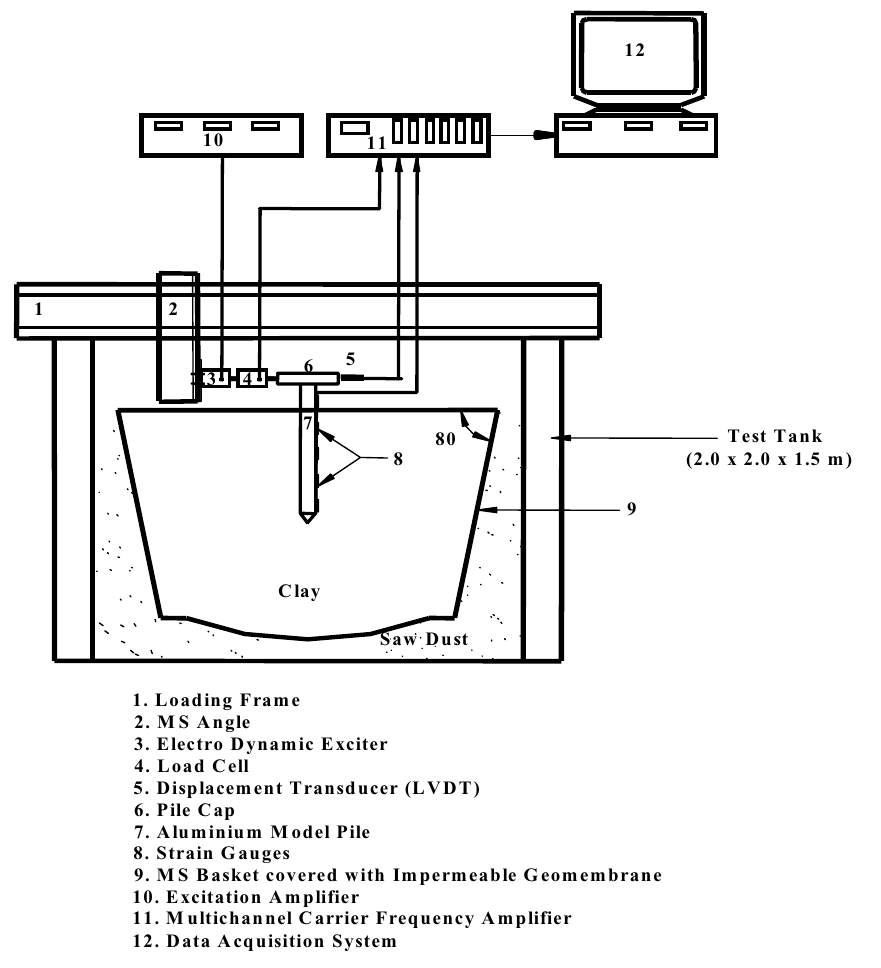
Fig. 3. Elastic half space test facility with